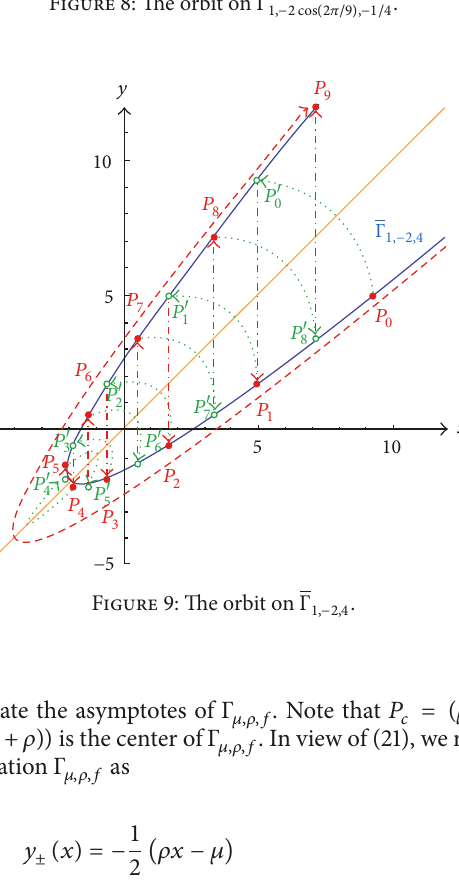
Figure 8: The orbit on Γ 1,−2 cos (2𝜋/9),−1/4 .